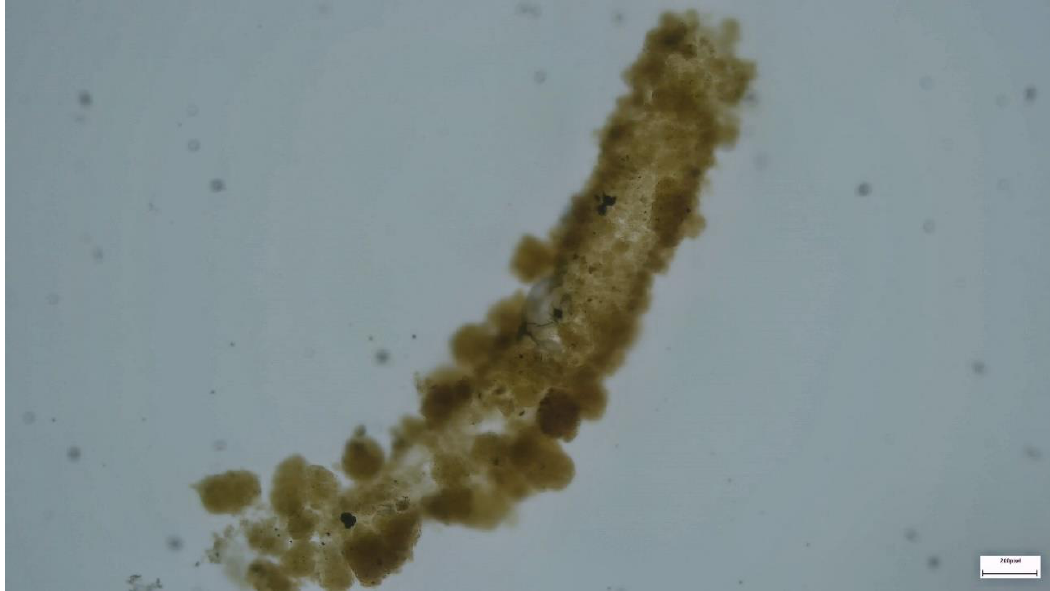
Figure 2. Living tube of Paratanytarsus grimmii from drinking water network. The living tubes reach a length of up to 5 cm, but they are damaged due to flushing out shear forces. The scale corresponds to 0.75 cm. Figure Michels © .